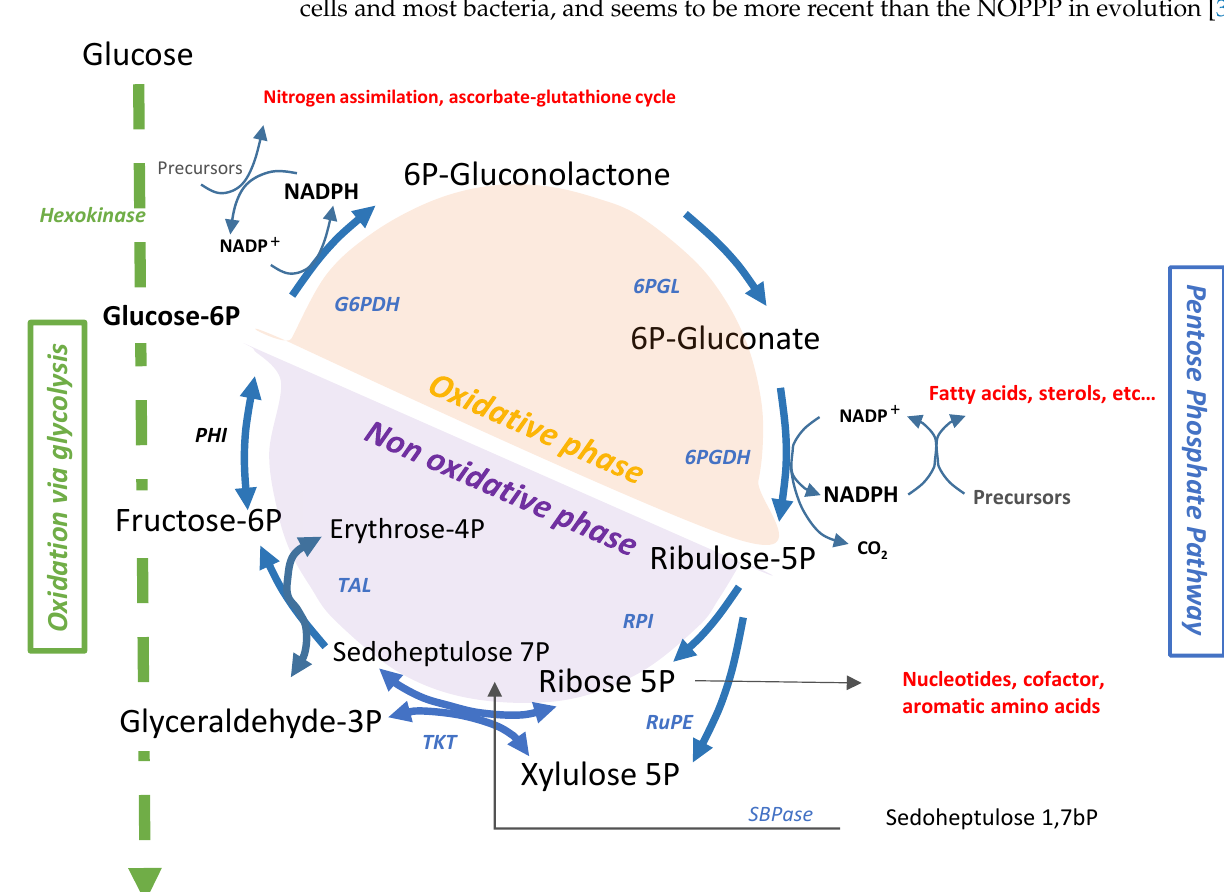
Figure 1. Overview of the reactions of the pentose phosphate pathway (PPP) and its connection to glycolysis. The glycolytic pathway is colored in green. The oxidative part of the PPP is col- ored in orange, the non-oxidative part in purple; one-headed arrows designate physiologically irreversible reactions, two-headed arrows reversible ones; abbreviation meanings: G6PDH,